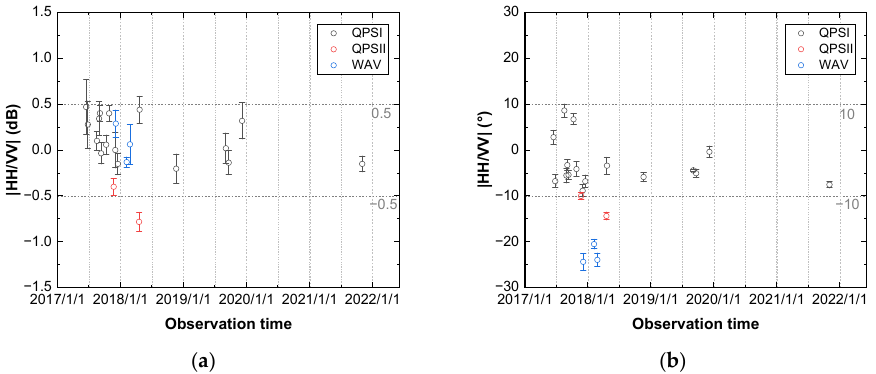
Figure 12. GaoFen-3’s co-pol channel imbalance evaluation with the Amazon rainforest datasets from June 2017 to November 2021, based on HH and VV channel ratios. ( a ) The co-pol channel imbalance amplitude; and ( b ) the co-pol channel imbalance phase.